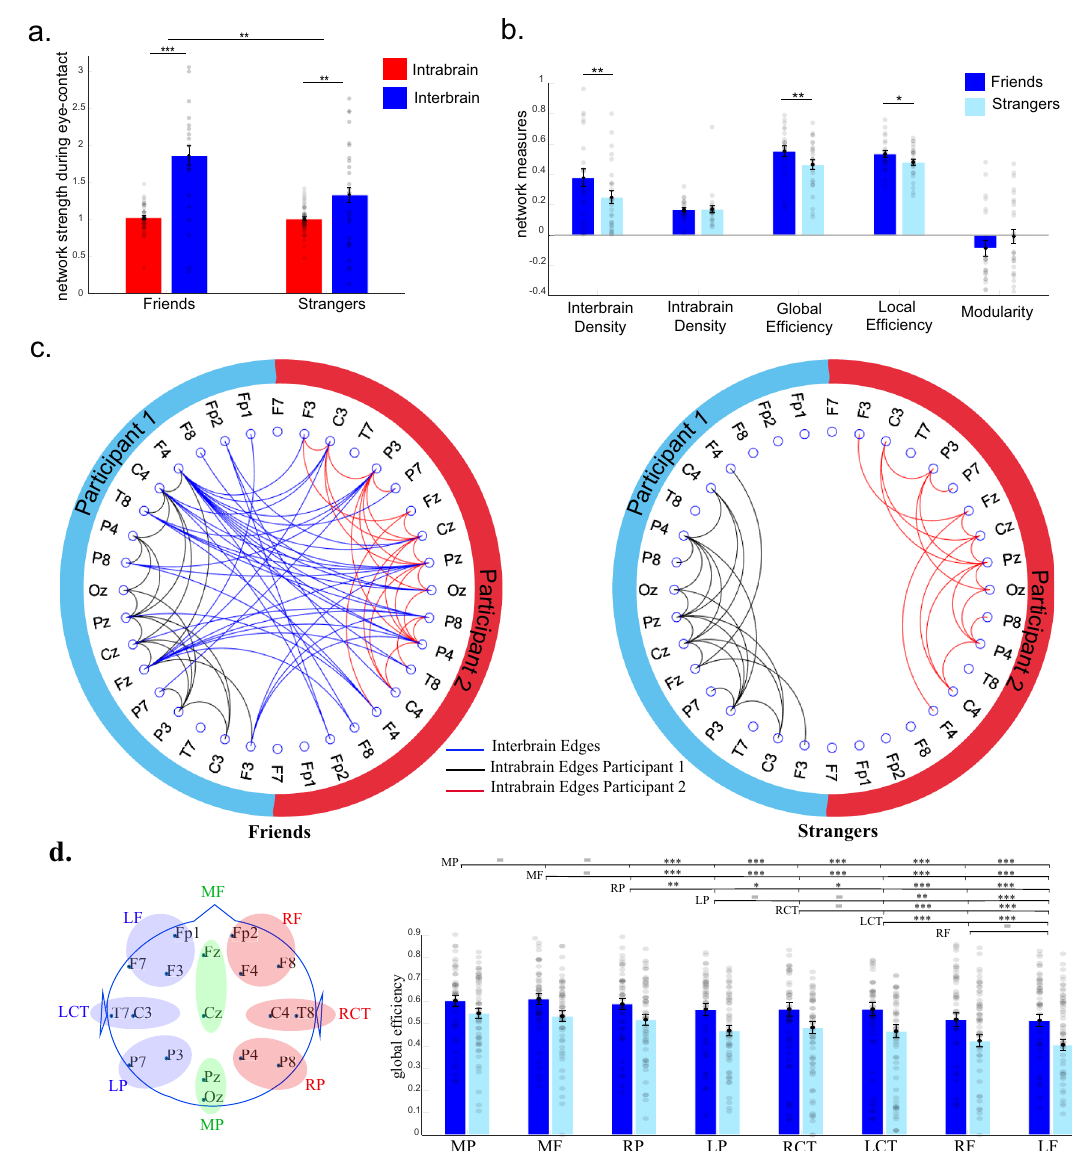
Fig. 4 Hyperbrain network during eye contact. a Intra- (red) and inter-brain (blue) network strength of friends and strangers measured as average of z-scores during eye-contact against control. The shaded dots represent each participant data ( n = 99/ the data of one participant was not plotted because its value was 3.90, which would increase the y-axis range making the error bars illegible). b Network measures of friends (dark blue) and strangers (light blue) during eye contact. The measures include inter-and intra-brain density ( n = 100), global and local ef fi ciency and modularity ( n = 50 dyads). These measures are based on the binary ciPLV networks. c ciPLV networks during eye contact, the edges represent the phase synchronization values which increased on average by more than 1 SD against the control task for friends (left) and strangers (right). Inter-brain edges are represented in blue, intra-brain edges of participants 1 are in black and 2 are in red. d Global ef fi ciency of each ROI (left hand side): MP mid posterior, MF midfrontal, RP right parietal, LP left parietal, RCT right centro-temporal, LCT left centro-temporal, RF right frontal, LF left frontal. Pairwise contrasts are Bonferroni corrected. Error bars represent ±1 SEM. *** p < 0.001/** p < 0.01/ * p < during eye contact, between brains (e.g., from leader to follower) and within brains. As explained above, the phase slope index (PSI) indicates whether the phase of a signal precedes the phase of the other signal in each frequency band. If there is a leader- follower effect, we expect the phase of the leader to precede the phase of the brain signals of the follower.